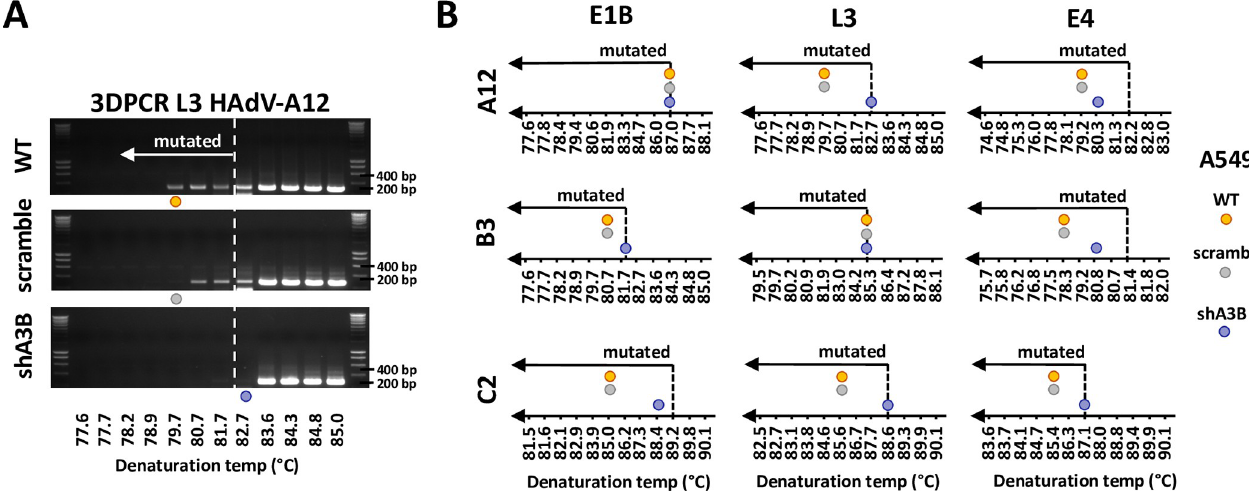
Fig 6. A3B knockout reduces the presence of hypermutated viral sequences. A549-WT, -scramble and -shA3B were infected with HAdV-A12, -B3 or -C2 and the intracellular DNA was extracted 48 hours post infection. 3DPCR reactions were conducted on the E1B, L3 and E4 genes. (A) Agarose gels illustrating 3DPCR specific for the L3 gene of the A12 strain. The dotted white line indicates the threshold between mutated and unmutated 3DPCR products. Low denaturation temperature amplicons were recovered in WT and scramble A549 cells. (B) Graphical representation of the 3DPCR results obtained for the 3 viral genes (E1B, L3 and E4), for the 3 viral strains (A12, B3 and C2) and for the 3 cell lines (WT, scramble and shA3B). The lowest denaturation temperatures allowing the production of the expected amplicons were represented on the gradients by colored circles.